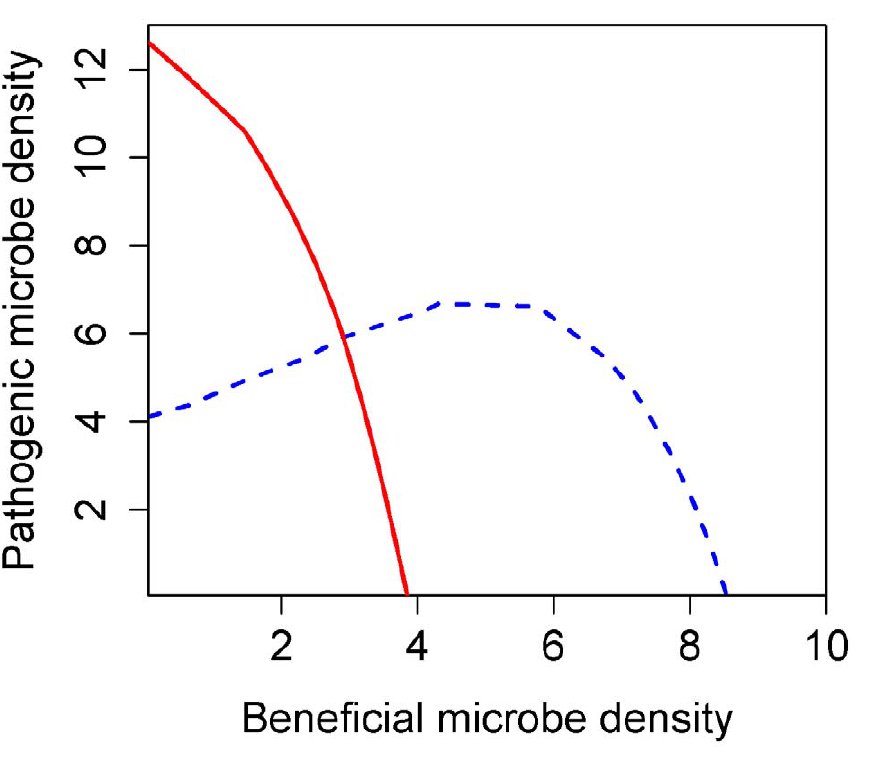
Figure 5. Numerically computed nullclines (beneficials: dashed blue curve, pathogens: solid blue curve) for the spatial model with the slower growth ‘‘baseline’’ parameter values listed in Table 2. The configuration of the nullclines implies stability of both the pathogen- only and the beneficials-only equilibria, with an unstable equilibrium at the intersection of the nullclines.